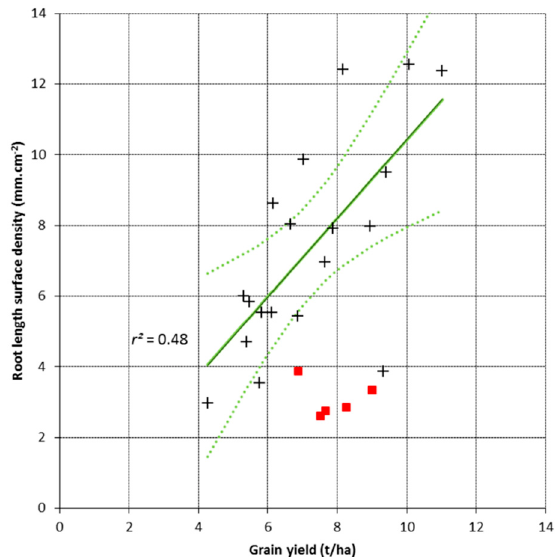
Figure 5. Correlation between wheat cultivars’ grain yield (t ha − 1 ) and total root length surface density (mm cm − 2 ) at anthesis stage (Z65). Scatterplot and regression line with 95% confidence band are shown for deep minirhizotron tubes (depth > 40 cm, n = 19) are shown. Data of the shallow minirhizotron tubes (depth < 40 cm, n = 5) are displayed as red dots. The equation of the regression line is y = 1.1x − 0.7.